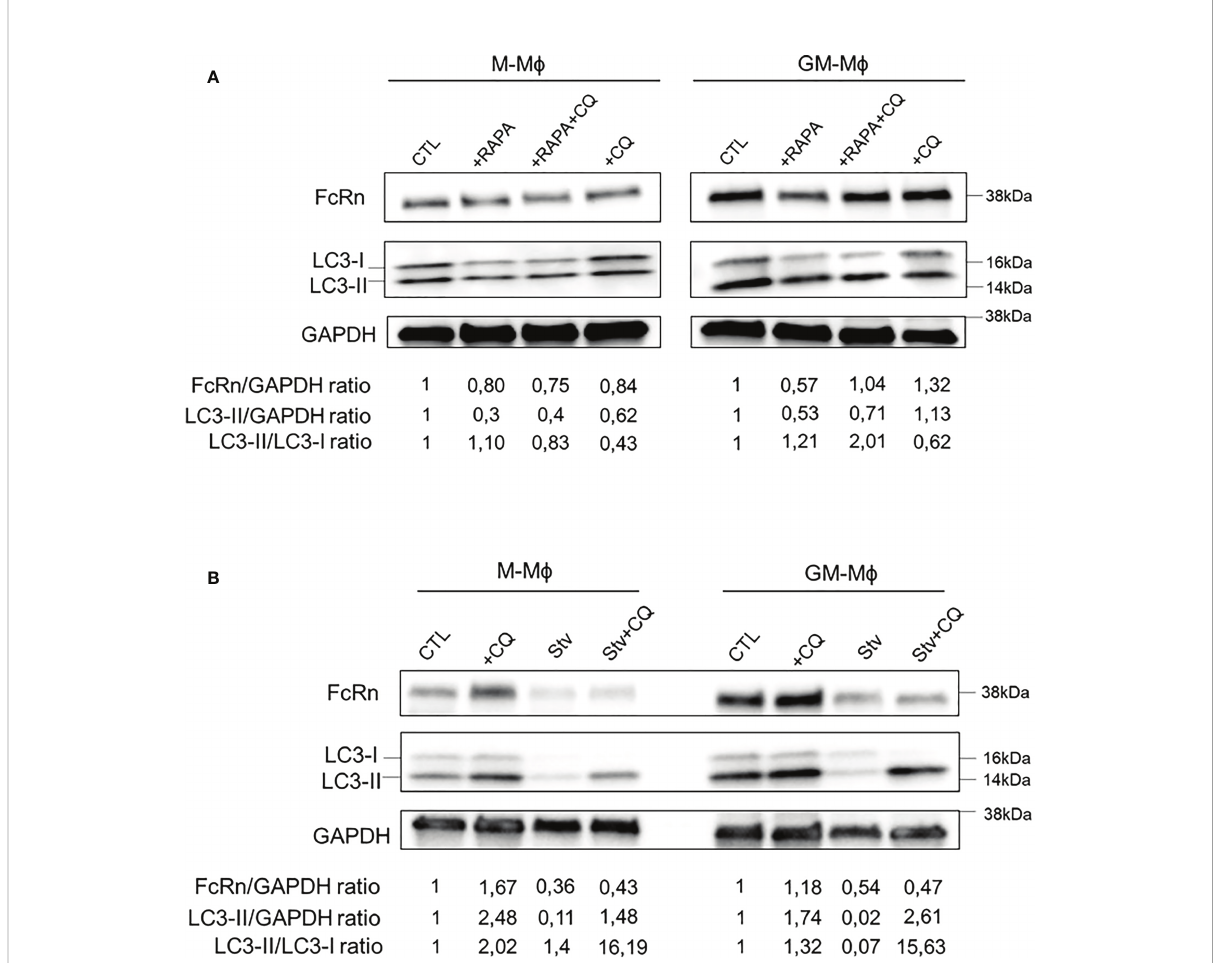
FIGURE 5 Autophagy activation with rapamycin or starvation modulates FcRn expression. (A) M-M f and GM-M f were treated on day 5 with rapamycin for 24 h and with chloroquine for the last hour. (B) M-M f and GM-M f were starved on day 6 for 4 h and chloroquine was added for the last hour. In A and B, levels of FcRn and LC3-I/II were examined by Western blot analysis and quanti fi ed. Values indicated on the bottom were normalized to GAPDH against the CTL. One representative blot in three experiments is presented for each treatment. M-M f , M-CSF – induced macrophages; GM-M f , GM-CSF – induced macrophages; CTL, control; RAPA, rapamycin (100 nM); CQ, chloroquine (15 µM); Stv,